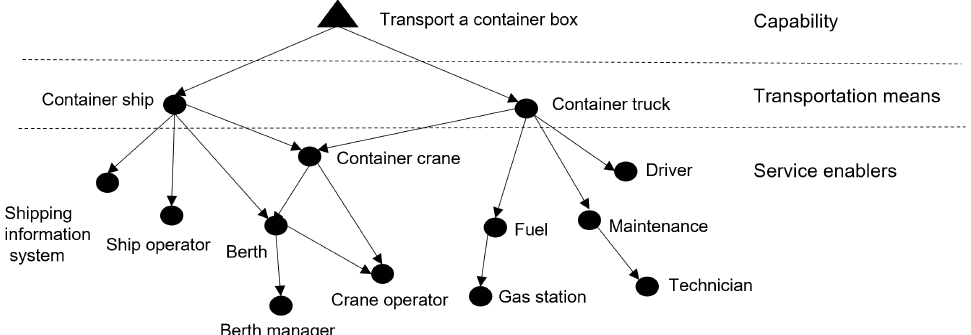
Figure 4. Example dependencies between service elements for container transportation, reproduced from [6].